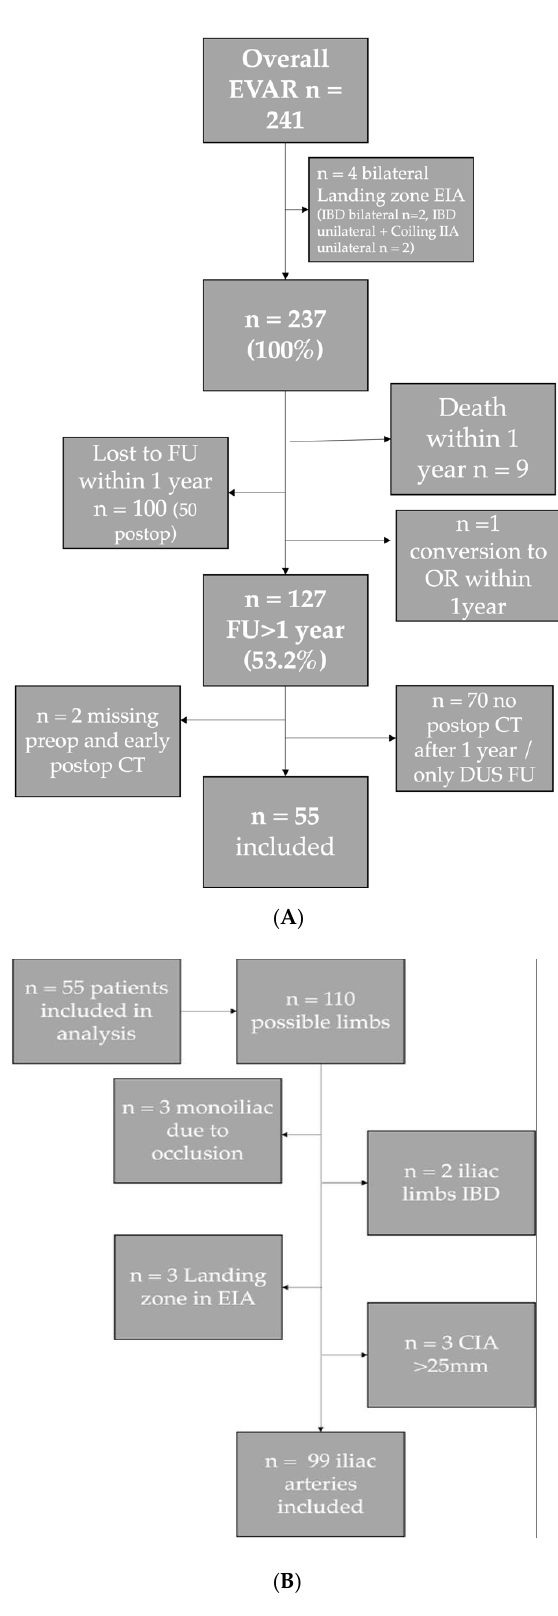
Figure 1. ( A ) Flow chart inclusion of patients. ( B ) Flow chart inclusion of iliac limbs. (Abbrevia- tions: AAA = abdominal aortic aneurysm, CIA = common iliac artery, EIA = external iliac artery; IIA = internal iliac artery; IBD = iliac branch device; DUS FU = Duplex ultrasound follow-up).